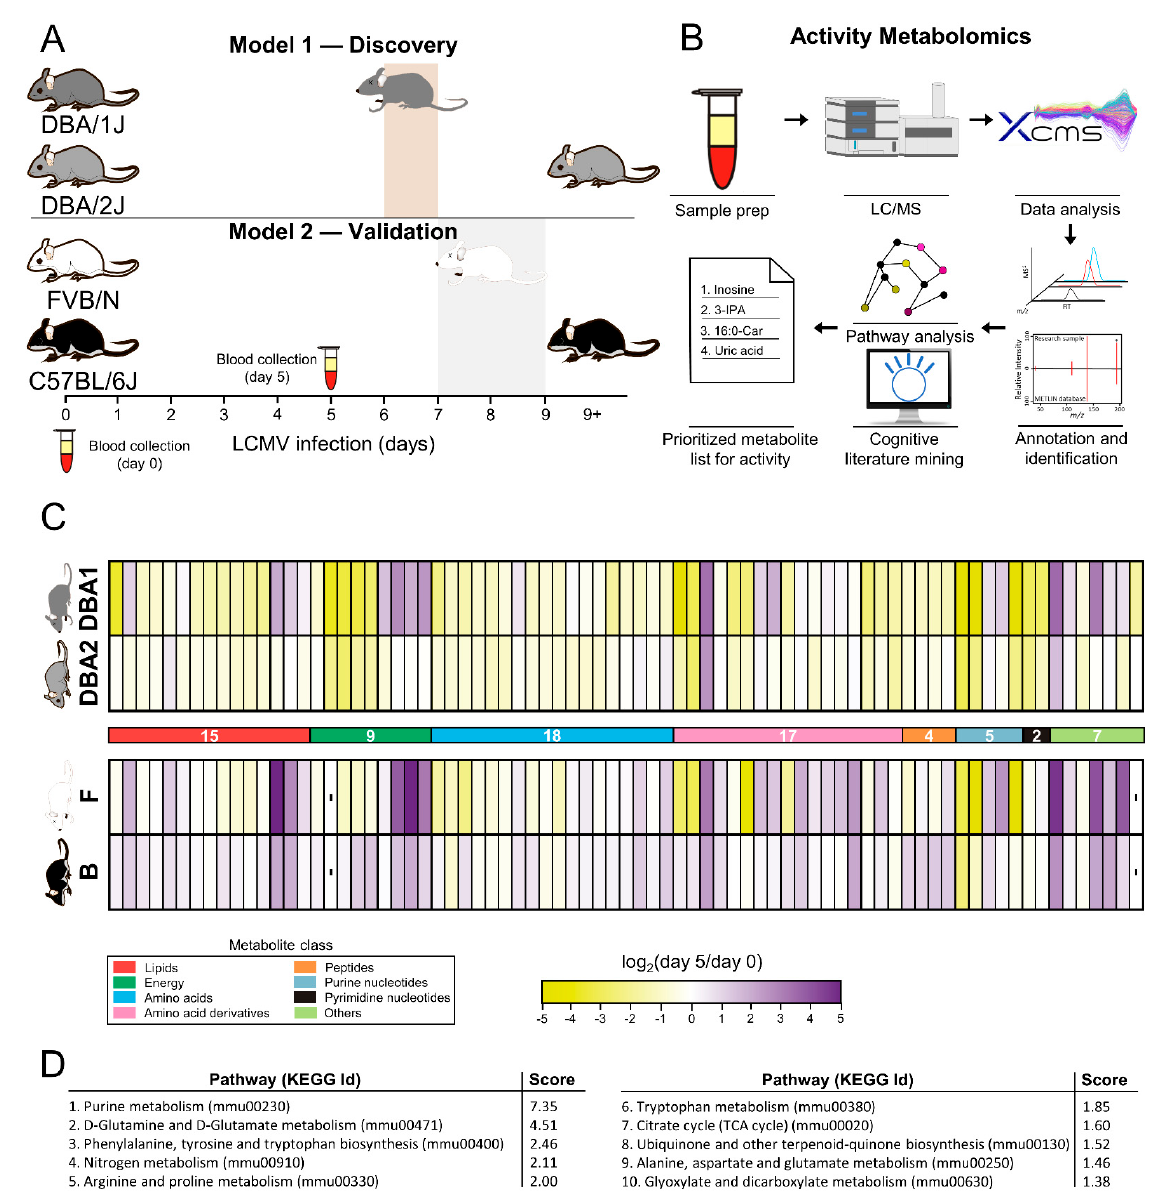
Figure 1. Untargeted metabolomic experiments were designed to identify dysregulated metabolites for later testing for activity. ( A ) Plasma was collected prior to virus inoculation (day 0) and after 5 days of infection, 24–48 h prior to DBA1 mice death. For validation, a similar analysis was performed separately on C57BL/6J (B mice) and FVB/N (F mice), a model that has shown similar behavior in the response to LCMV Cl13. The known phenotypic outcomes in both models enhanced our chance of observing relevant metabolites associated with CTL responses and survival. ( B ) Untargeted metabolomics pathway analysis and cognitive-driven accelerated literature mining were used to prioritize those metabolites that might play significant roles in mediating the differential T-cell responses. ( C ) Over 70 metabolites were found to be dysregulated in the DBA model between day 0 and 5 of LCMV Cl13 infection ( q < 0.05, one-way ANOVA followed by a Kruskal–Wallis nonparametric test). All but two metabolites (citric acid and N-acetylmuramic acid) were also detected in the validation model. Metabolite changes at day 5 were calculated using day 0 levels as a reference and represented in a heatmap using a logarithmic scale. ( D ) Pathway analysis at day 5 after inoculation was carried out to predict the metabolic pathways that were more dysregulated between mice that survived and